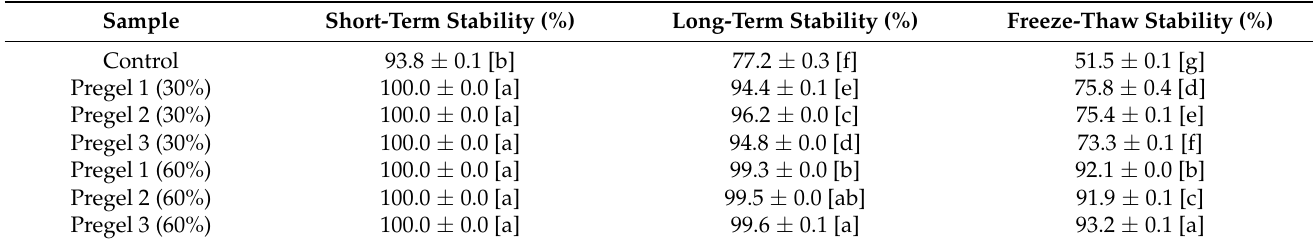
Table 3. Stability (%) of the oil-in-water emulsions after varying storage time conditions and freeze- thaw